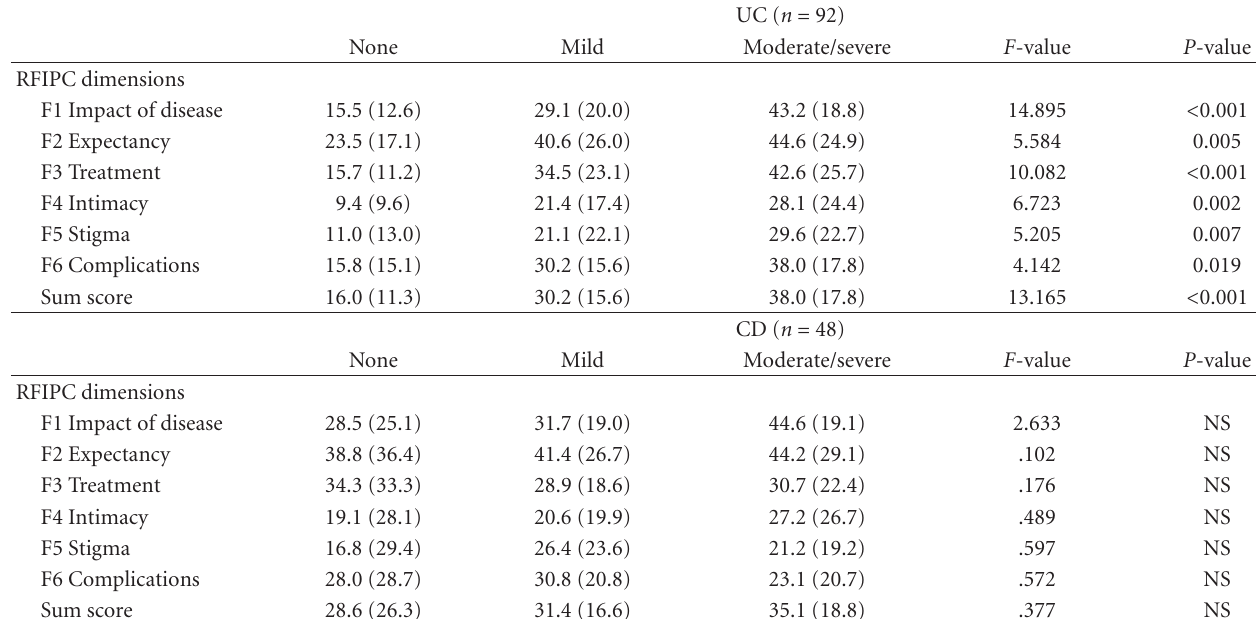
Table 3: Determination of the RFIPC’s ability to discriminate between IBD symptom severity scores at